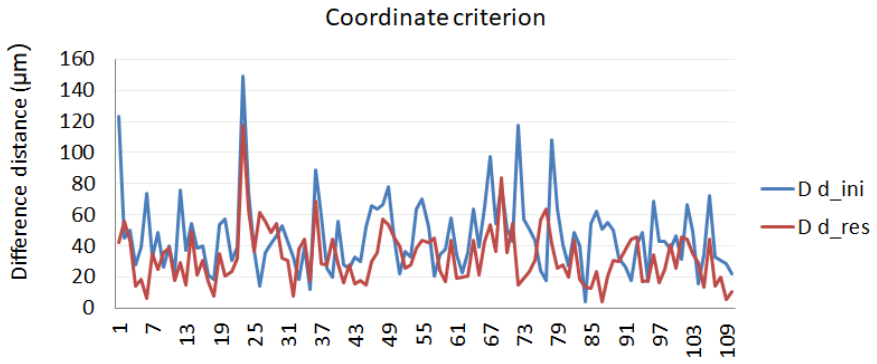
Figure 11. Calibration evaluation according to the coordinate criterion.